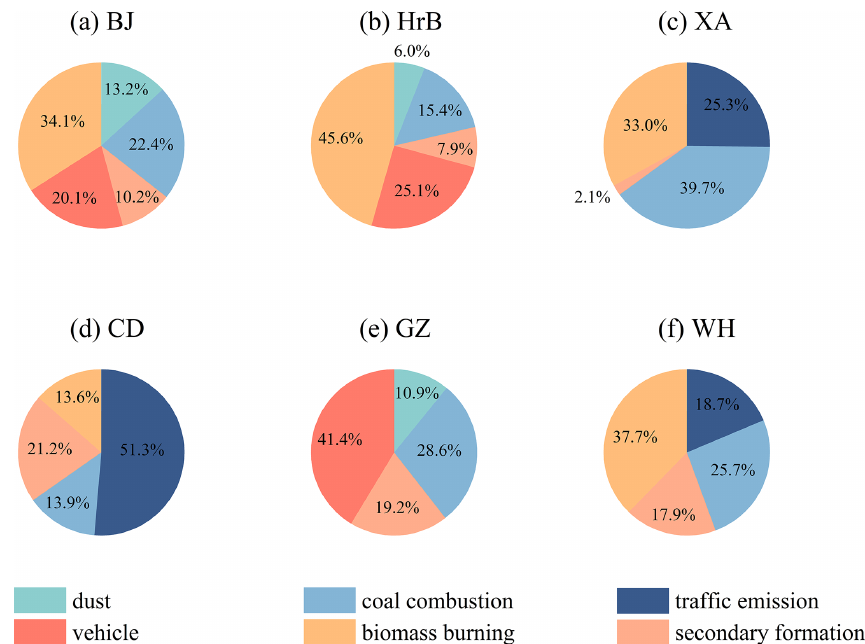
Figure 5. The source contribution to BrC using multilayer perceptron neural network analysis in (a) BJ, (b) HrB, (c) XA, (d) CD, (e) GZ, and (f)